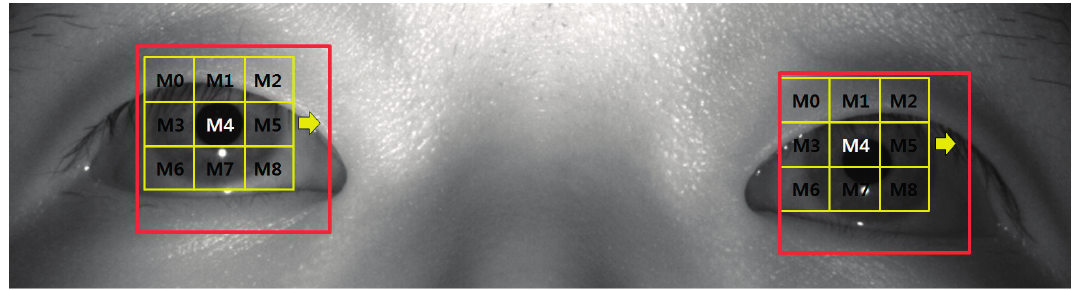
Figure 9. Example of detecting pupil regions using sub-block-based template